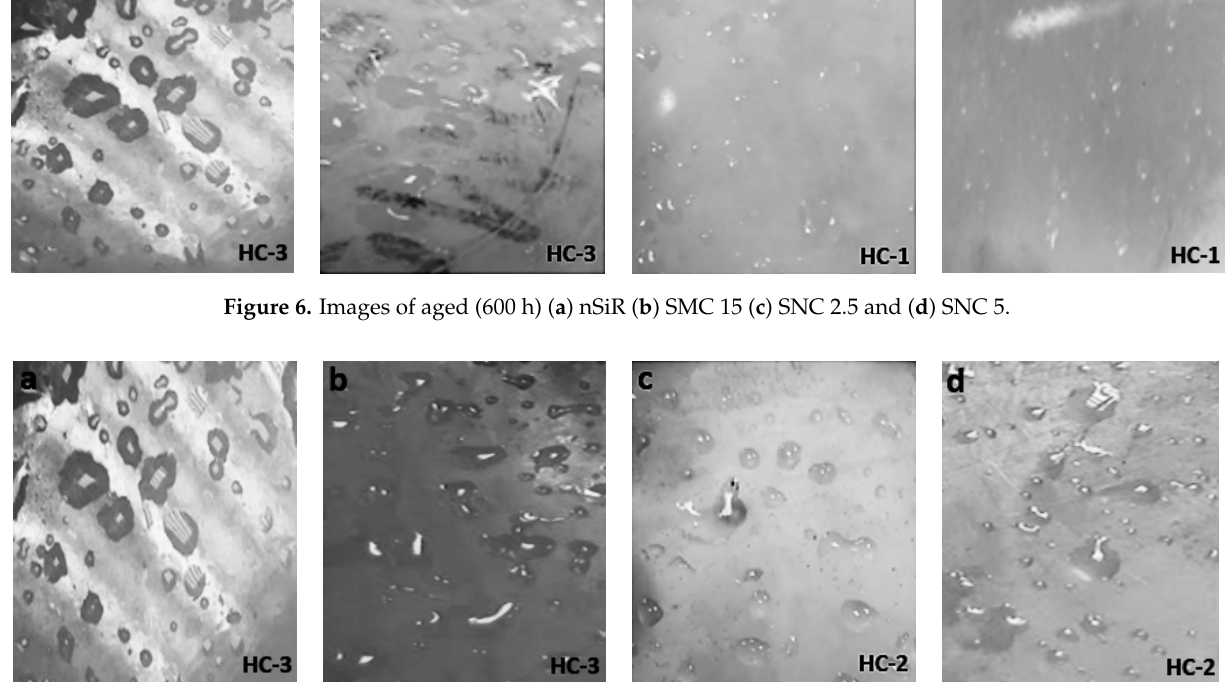
Figure 7 Images of aged (800 h) ( a ) nSiR ( b ) SMC 15 ( c ) SNC 2.5 and ( d ) SNC 5.